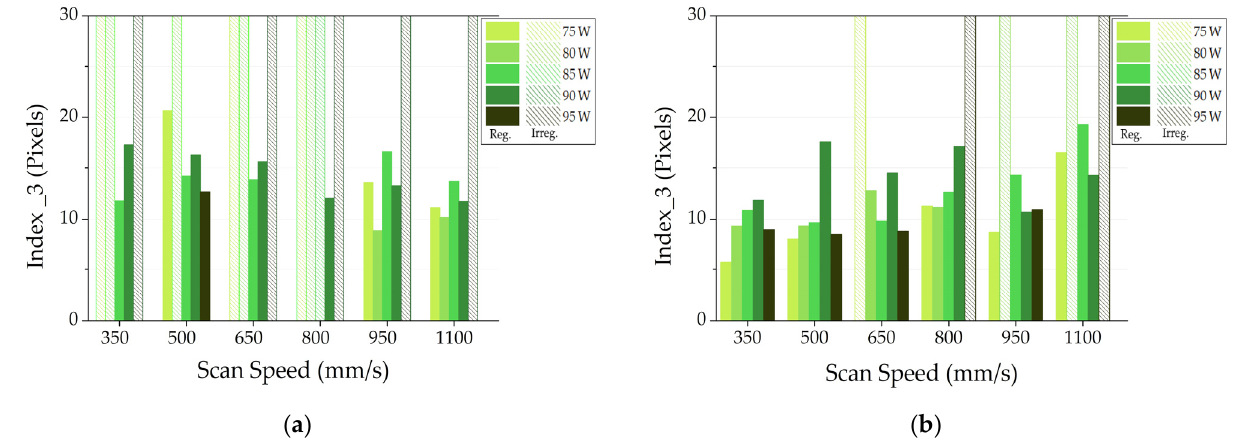
Figure 8. Index 3 for AlSi10Mg jobs built with a layer thickness of 20 μ m ( a ) or 25 μ m ( b ).